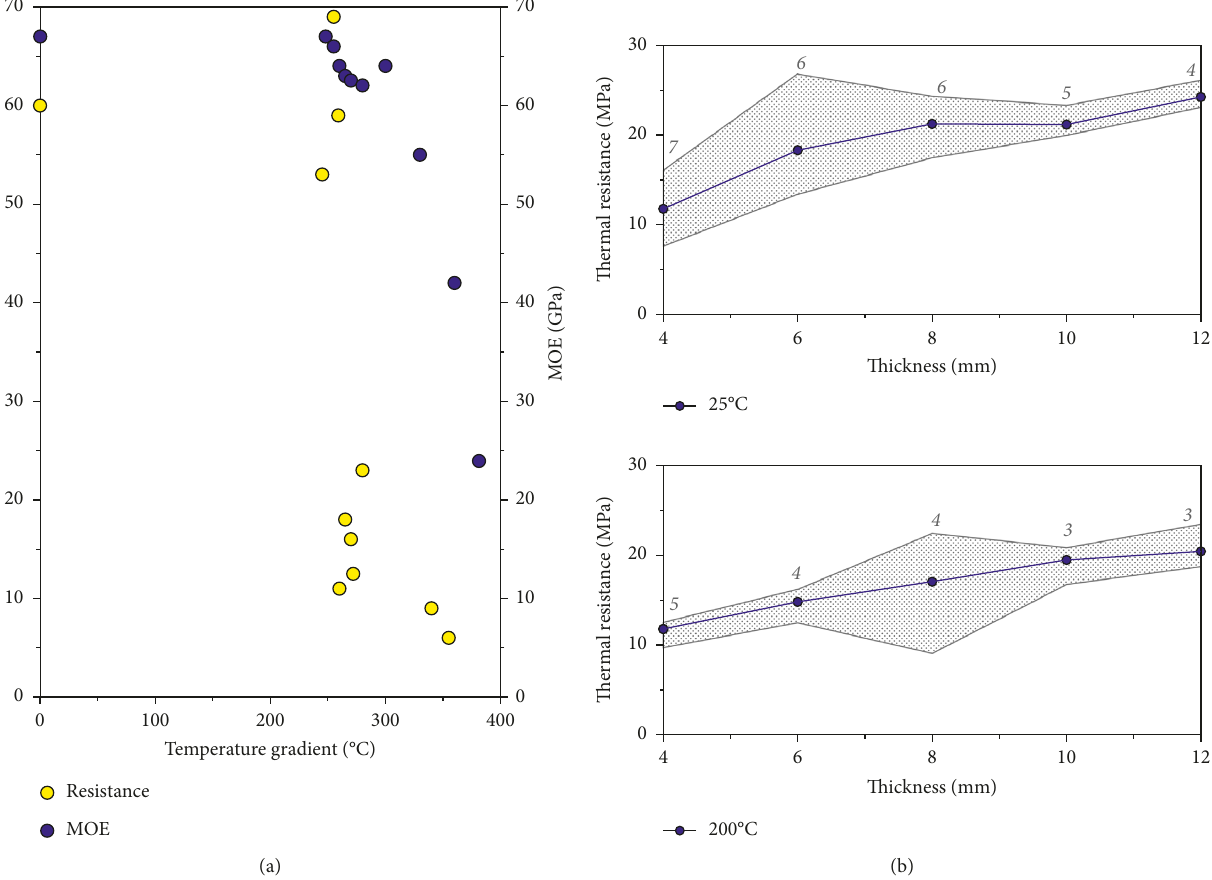
Figure 6: Thermal characterization of SLS glass. (a) Variation of MOE and resistance, under thermal shock [64], and (b) dependency of thermal shock resistance to glass thickness (in gray italic, the number of tests for each thickness), in accordance with [65].